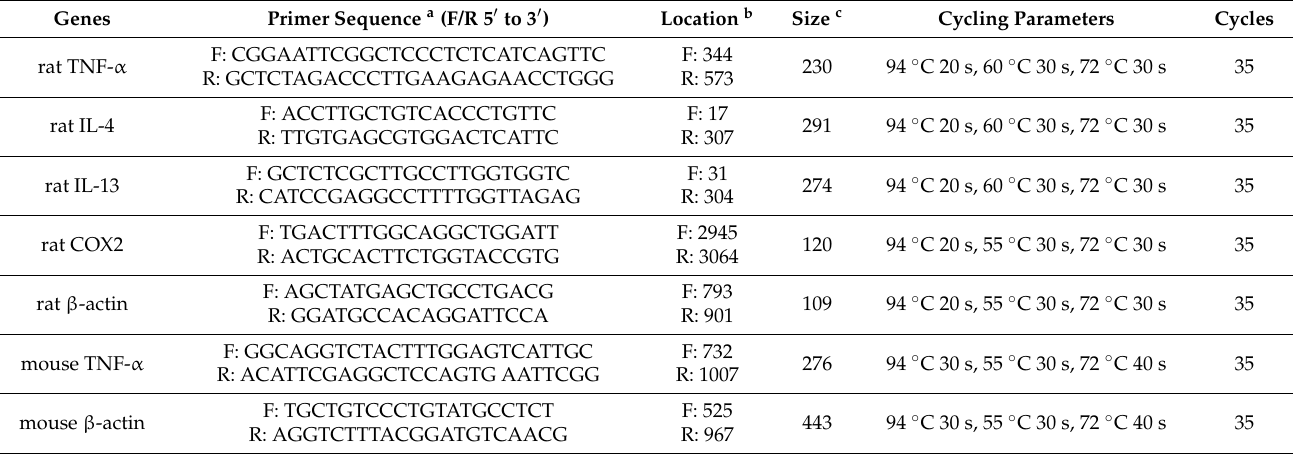
Table 2. The primer sequences and cycling parameters used for